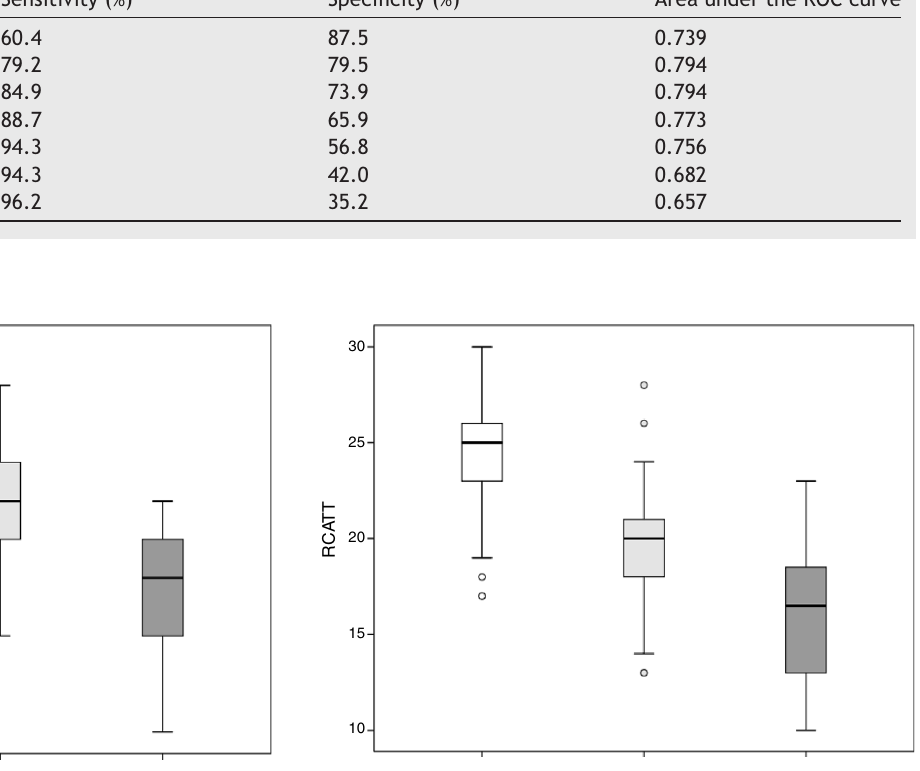
Table 1 Sensitivity, specificity, and area under the receiver operating characteristic (ROC) curve of different Rhinitis Control Assessment Test (RCAT) cutoffs to define rhinitis control. Cutoff point